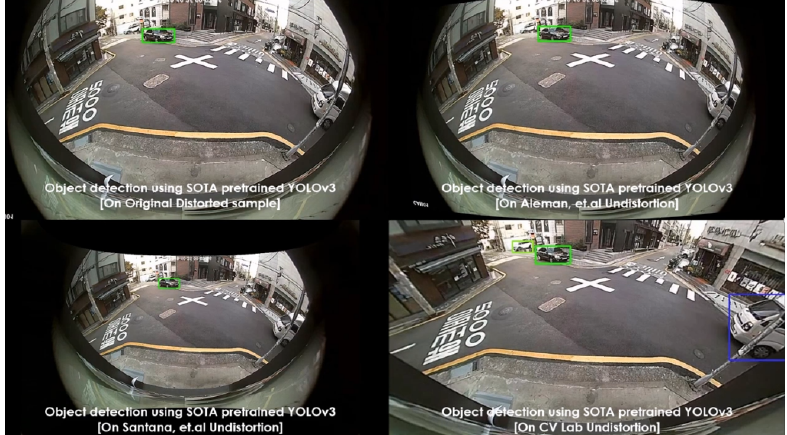
Figure 12. Pretrained YOLOv3 object detection on various rectified 190 ◦ fish-eye frames: van detected along the edge in the proposed rectified algorithm.